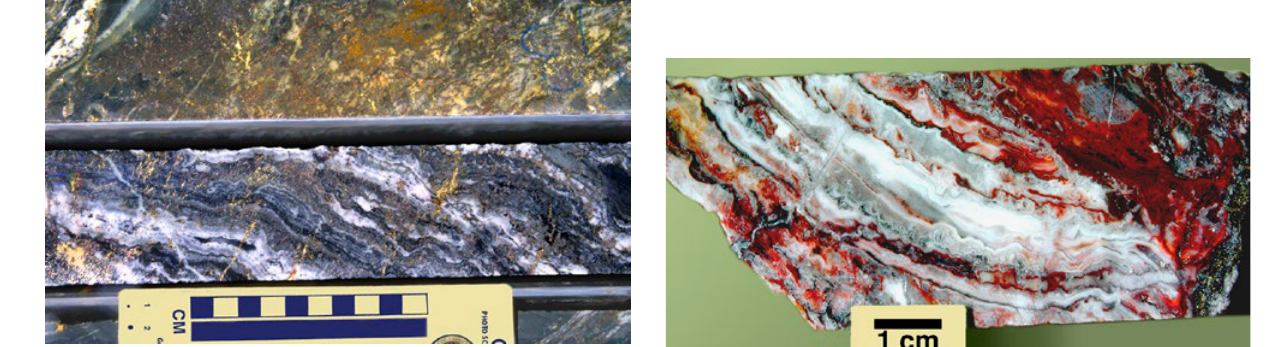
Figure 45. Orbicular spherulites occur in vein quartz from the Golden Plateau Mine at Cracow in Queensland. Concentric zones of radial quartz crystals surround central orbicular cores which are richer in chlorite. These concretionary structures depend on synere- sis in the polymeric silicic acid precursor and the radial crystallisa- tion pattern is typical of the outgrowth round nuclei in gels.